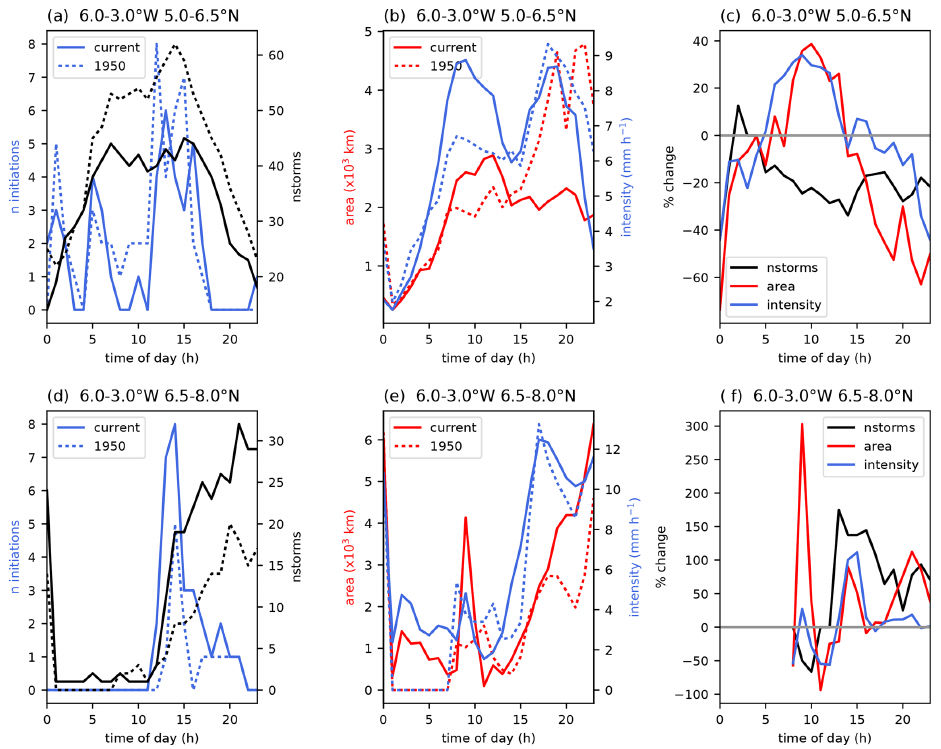
Figure 11. As for Fig. 9 but for cross sections 6–3 ◦ W and two different sub-regions. Table 1. Comparison of whole-day mean variables over 16 ◦ W–16 ◦ E, 0–15 ◦ N (deforested land unless specified otherwise), estimated from figures in A08, B16, and C20 if not given as region